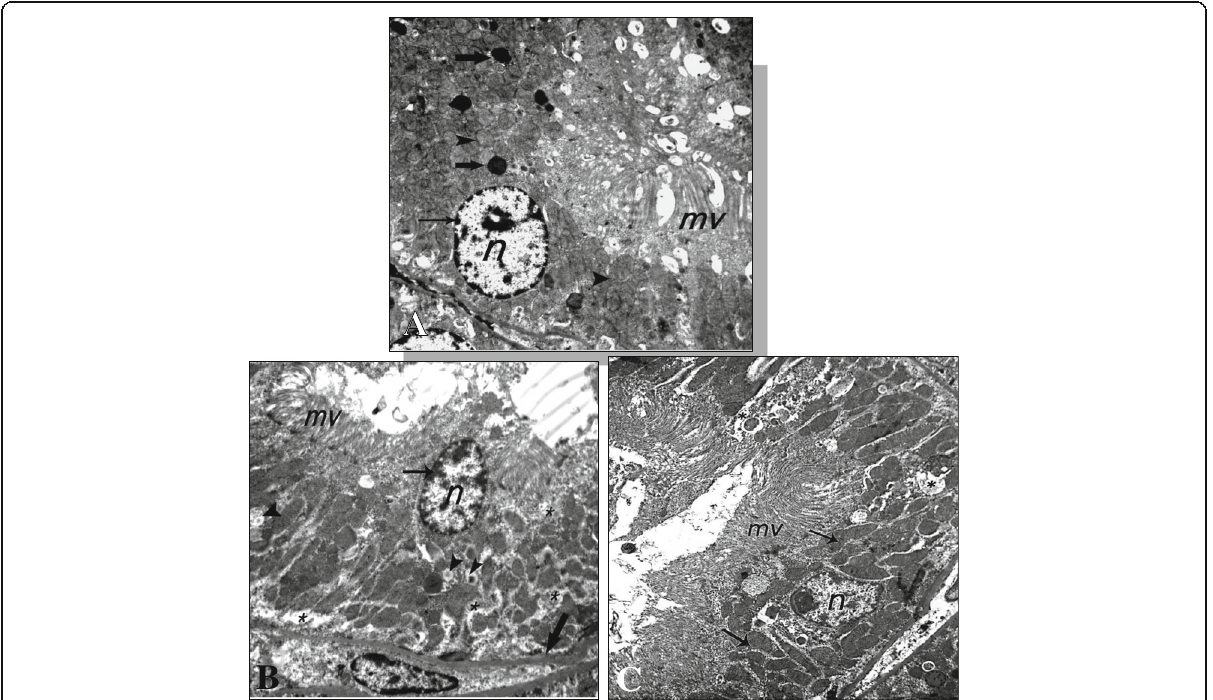
Fig. 5 Electron photomicrography of a part of a proximal convoluted tubule. a (control rat), section showing nucleus (n) containing marginally arranged chromatin material (thin arrows), mitochondria (arrowheads) with intact cristae, many long and dense apical microvilli (mv), and lysosomes (thick arrows). Note the intact cytoplasm. b Section in CA group showing thickening areas of the basement membrane (thick arrow), partial loss of apical microvilli (mv), degenerated nucleus (n) with regressive size, and a high dense chromatin (thin arrow), rarefied cytoplasm (asterisk), some degenerated mitochondria with destructed cristae (arrowheads). c Section in CA + FU group showing: nearly a normal appearance of the nucleus (n) and partial long and dense apical microvilli (mv) as well as rarefied of some parts of cytoplasm (asterisk) can be noted with some healthy parts (arrows). (Uranyl acetate, ×